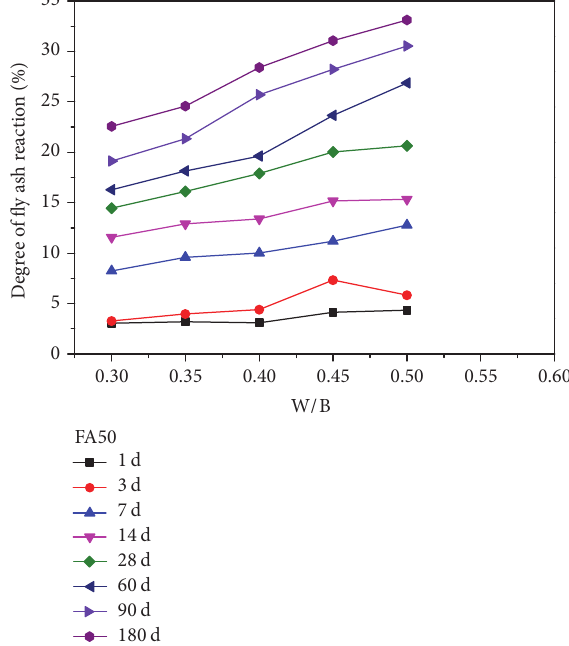
Figure 3: Effect of W/B ratio on fly ash reaction